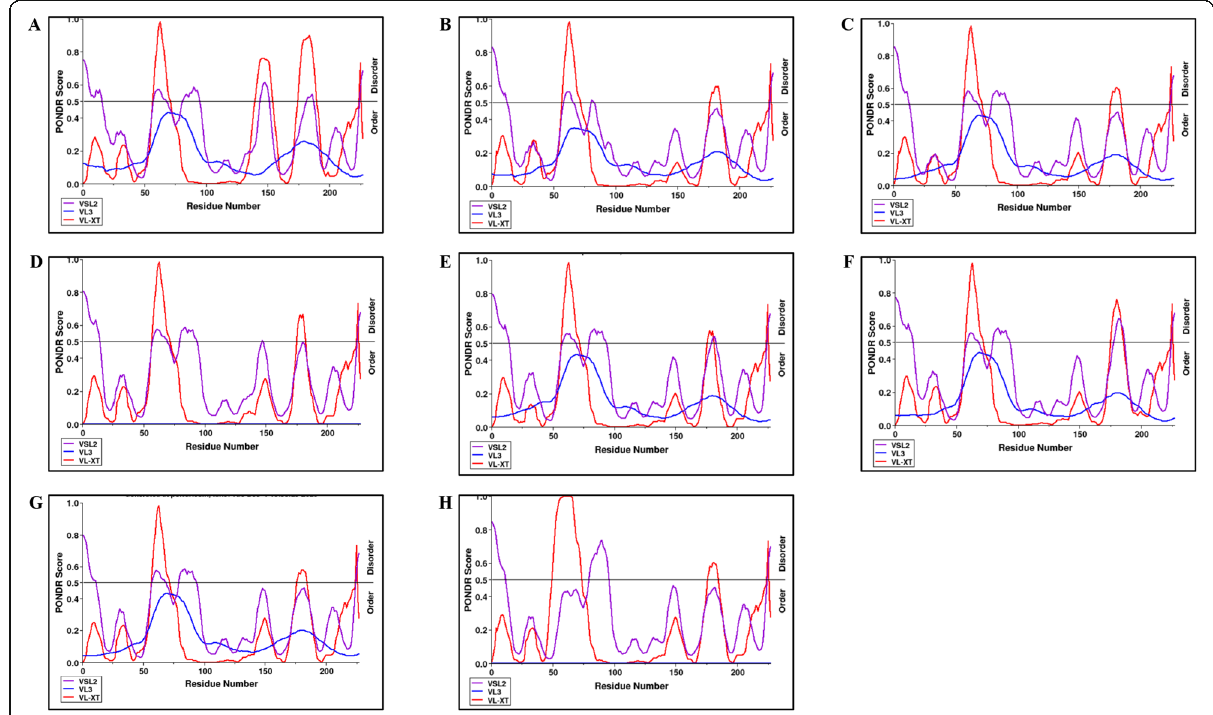
Fig. 3 Analysis of intrinsic disorder predisposition of HEV YDR. ( A ) JF443720 (GT 1); ( B ) M74506 (GT 2); ( C ) AB222182 (GT 3); ( D ) GU119961 (GT 4); ( E ) AB573435 (GT 5); ( F ) AB602441 (GT 6); KJ496143 (GT 7); and ( H ) KX387865 (GT 8). Graphs A – H represent the intrinsic disorder profiles of YDR sequences of HEV. Disorder probability was calculated using three members of the family PONDR (Prediction of Natural Disordered Regions), i.e., VLXT, VL3, and VSL2. A threshold value of 0.5 was set to distinguish between ordered and disordered regions along the genome (dashed line). Regions above the threshold are predicted to be